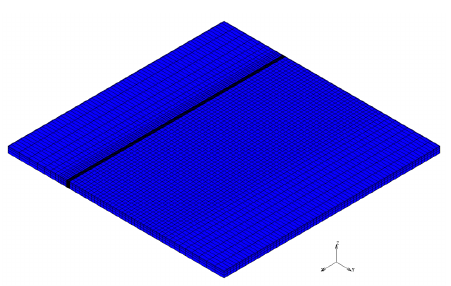
Figure 1. Mesh model using the coupled thermal–mechanical analysis.